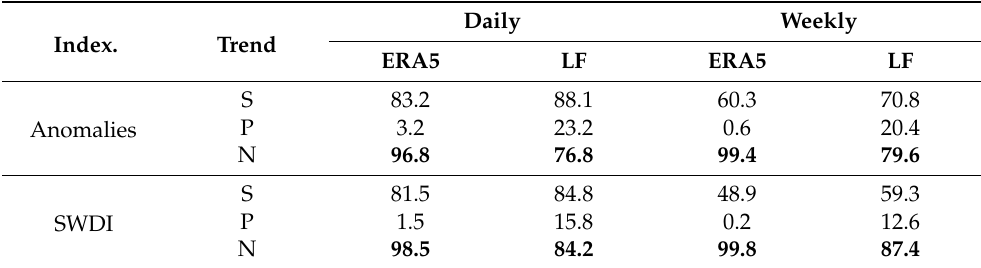
Table 1. Percentage of significant (S), positive (P), and negative (N) trends at daily and weekly scales for the whole series. Maximum trend percentage values are in bold. Daily Weekly Index. Trend ERA5 LF Anomalies